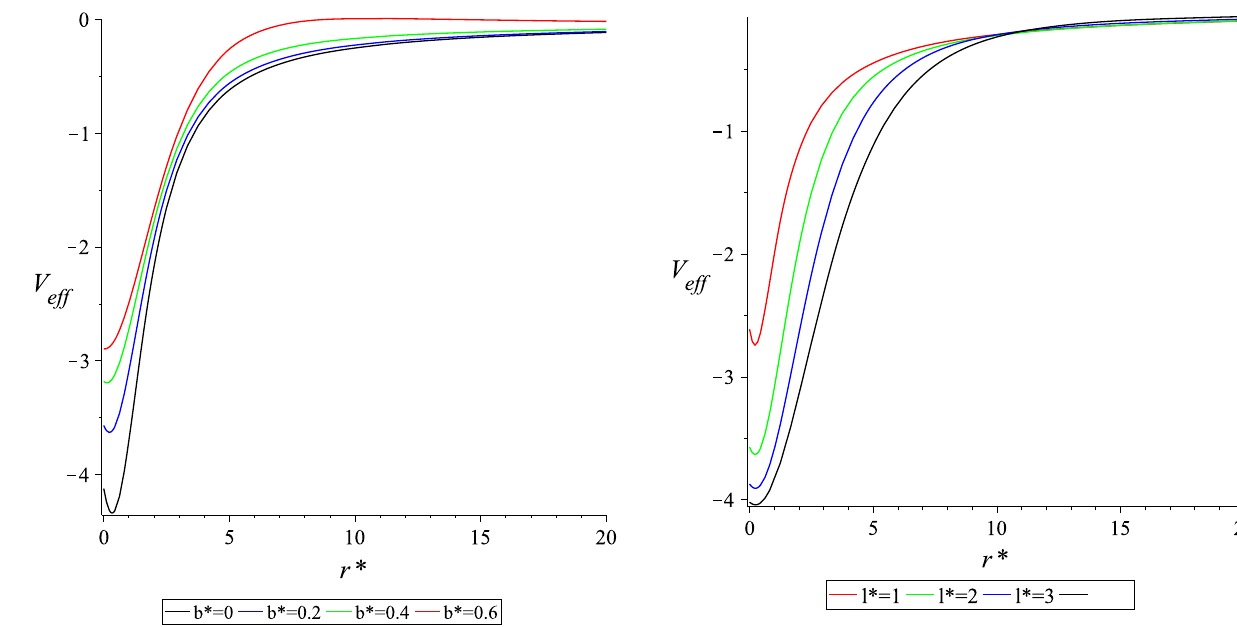
Fig. 4 Effective potentials for timelike particle with E = 1, L ∗ = 2, b ∗ = 0 . 2, and the rotational parameter a ∗ = 0 . 5. The NUT parameter l ∗ varies from 1 to 4